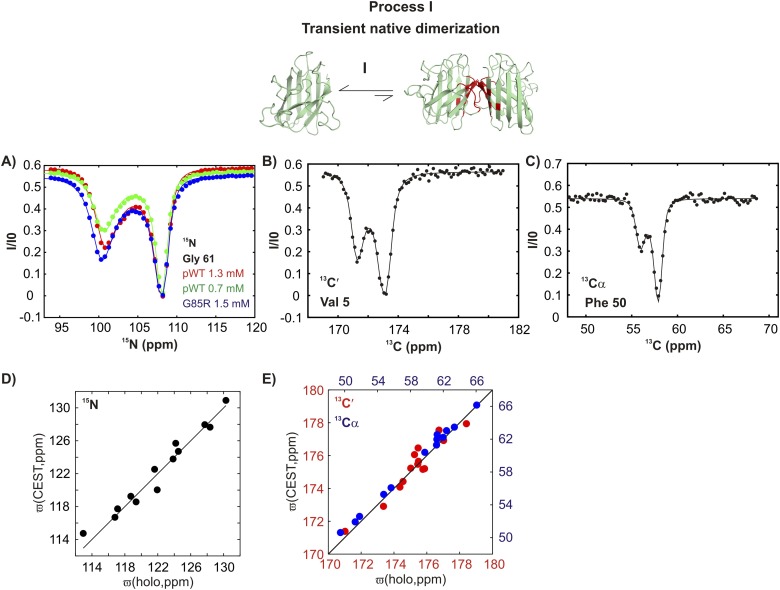
pWT apoSOD12SH transiently samples a native dimer conformation.(A) 15N-CEST profiles for G61 of pWT apoSOD12SH that reports on the dimerization process, red: 1.3 mM, green: 0.7 mM and G85R apoSOD12SH (blue: 1.5 mM). The G85R mutation does not interfere with transient native dimer formation as indicated by the large minor state dip. Profiles plot the intensity of the ground state peak (I) as a function of the position of the perturbing B1 field (31 Hz), normalized to the corresponding intensity obtained from a spectrum recorded without the CEST element (I0) (Vallurupalli et al., 2012). 13C′- (B) and 13Cα- (C) CEST profiles for residues V5 and F50, respectively. Correlations of 15N (D), 13C′ (E, red) and 13Cα (E, blue) CEST-derived excited state chemical shifts, (ϖ, ppm, y-axis) of apoSOD12SH with the ground state shifts (Banci et al., 2002a) of Cu2Zn2SOD1S–S (x-axis) for residues localized to regions involved in transient dimerization.